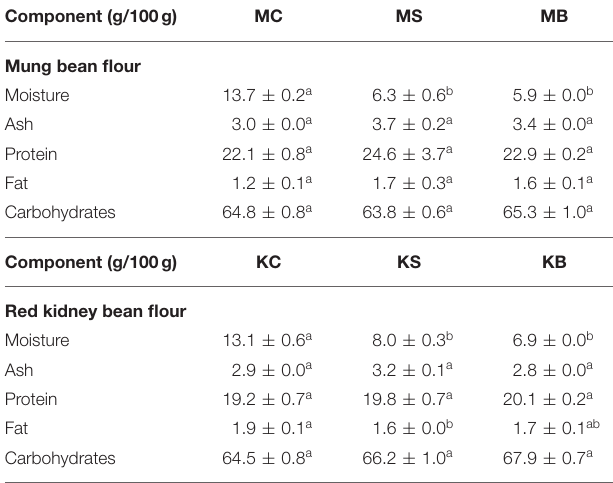
TABLE 2 | Proximate composition of bean